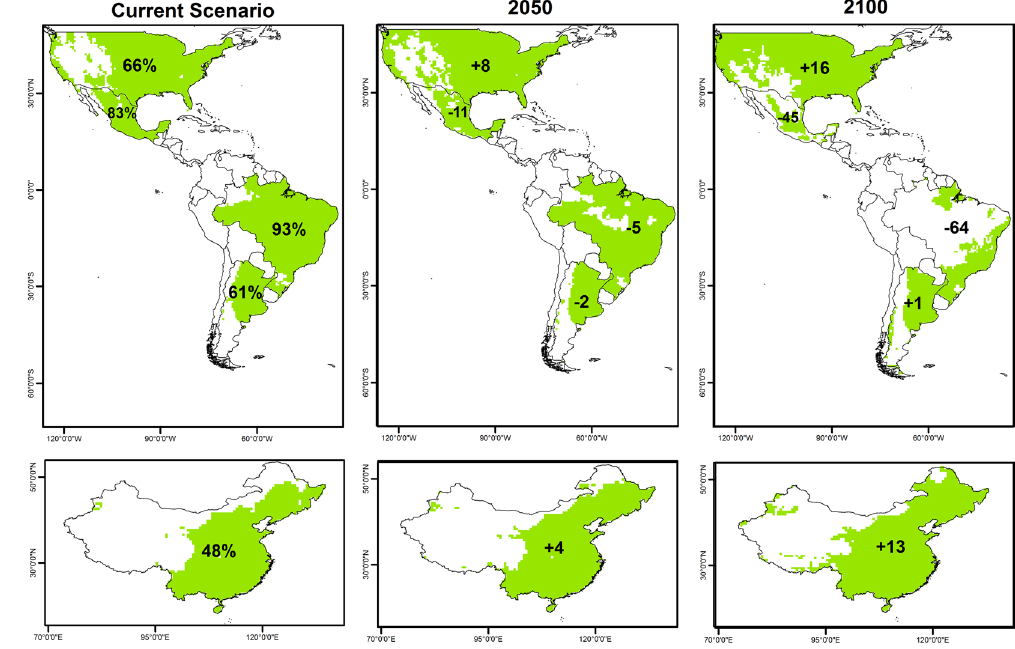
Figure 4. Changes in areas of climatic suitability for maize among the current five major maize producers. For example, under current conditions China is modelled to have 48% of its territory with some climatic suitability for maize cultivation, with an increase of 4% expected by 2050 and 5% by 2100. ArcMap 10.2 (http://desktop.